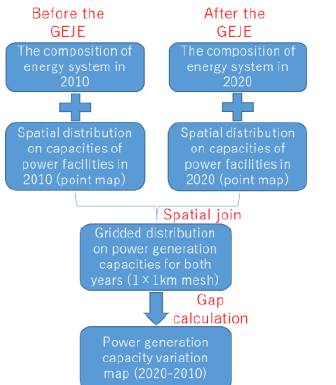
Figure 2. The workflow used to show the evidences on the development of energy system in Fukushima since the GEJE